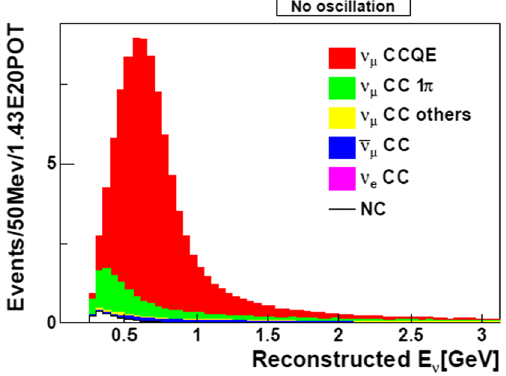
Fig. 44 The reconstructed neutrino energy of single muon events in the simulation for T2K without oscillation. Comparing with the K2K case in Fig. 39, the inelastic contamination is much smaller with the T2K off-axis beam due to the reduced high energy tail